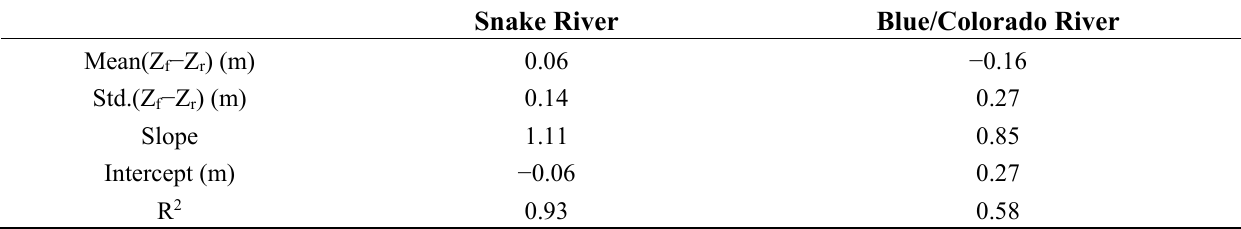
Figure 16. Optimal single band water depth map for: ( a ) the Snake River, coordinates are in UTM 12N (NAD83), and ( b ) the Blue/Colorado River, coordinates are in UTM 13N (NAD83)). Table 7. Best Performance for single band bathymetric LiDAR for both the Snake River and The Blue/Colorado